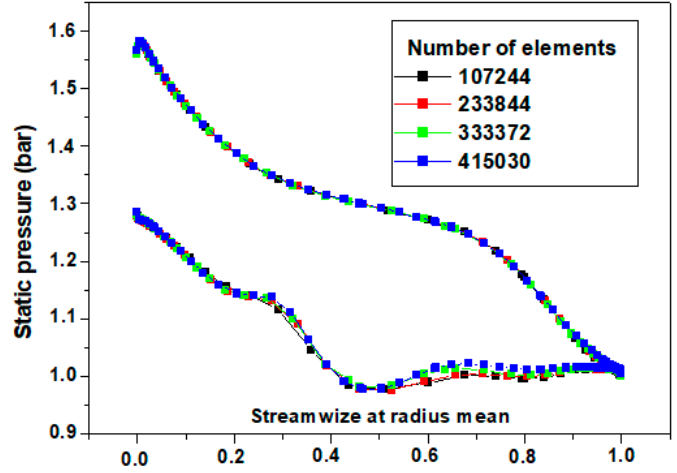
Figure 7. Effect of element number on static pressure [42].